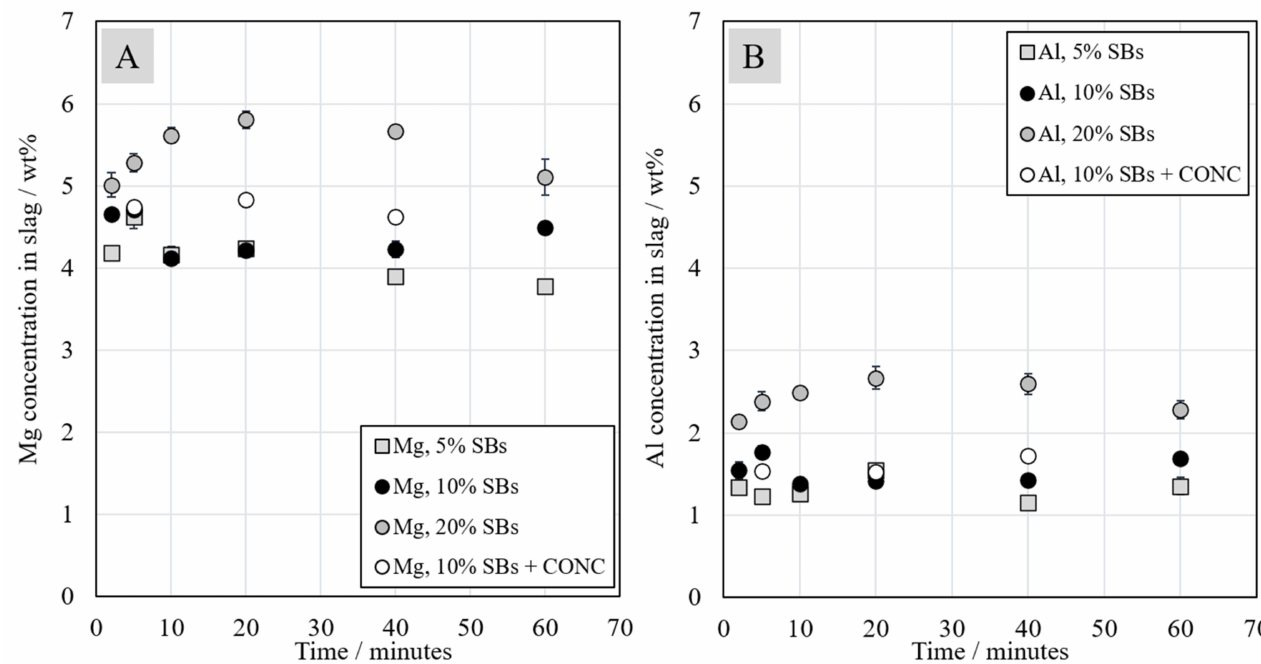
Figure 5. Magnesium ( A ) and aluminum ( B ) concentrations in the slag as a function of contact time at 1350 ◦